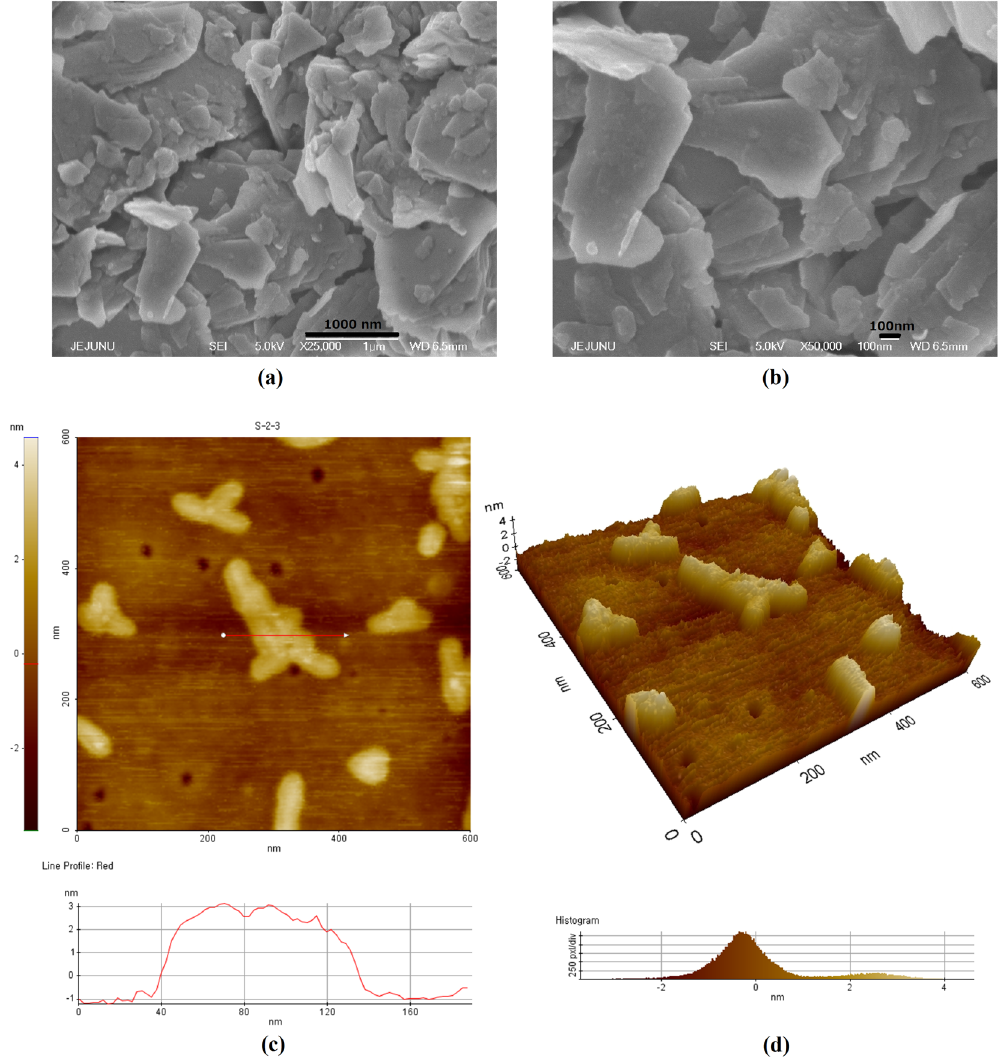
Figure 1. SEM and AFM of the active layer showing. ( a ) MoS 2 active layer with highly porous surface, ( b ) 2D MoS 2 flakes, ( c ) 2D surface profile and AFM line profile, and ( d ) 3D surface profile by